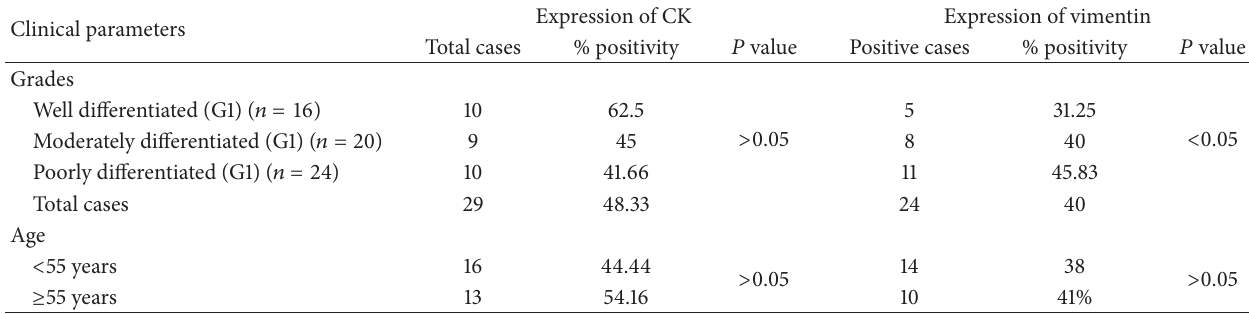
Table 1: Expression pattern of cytokeratin and vimentin in squamous cell carcinoma cases.